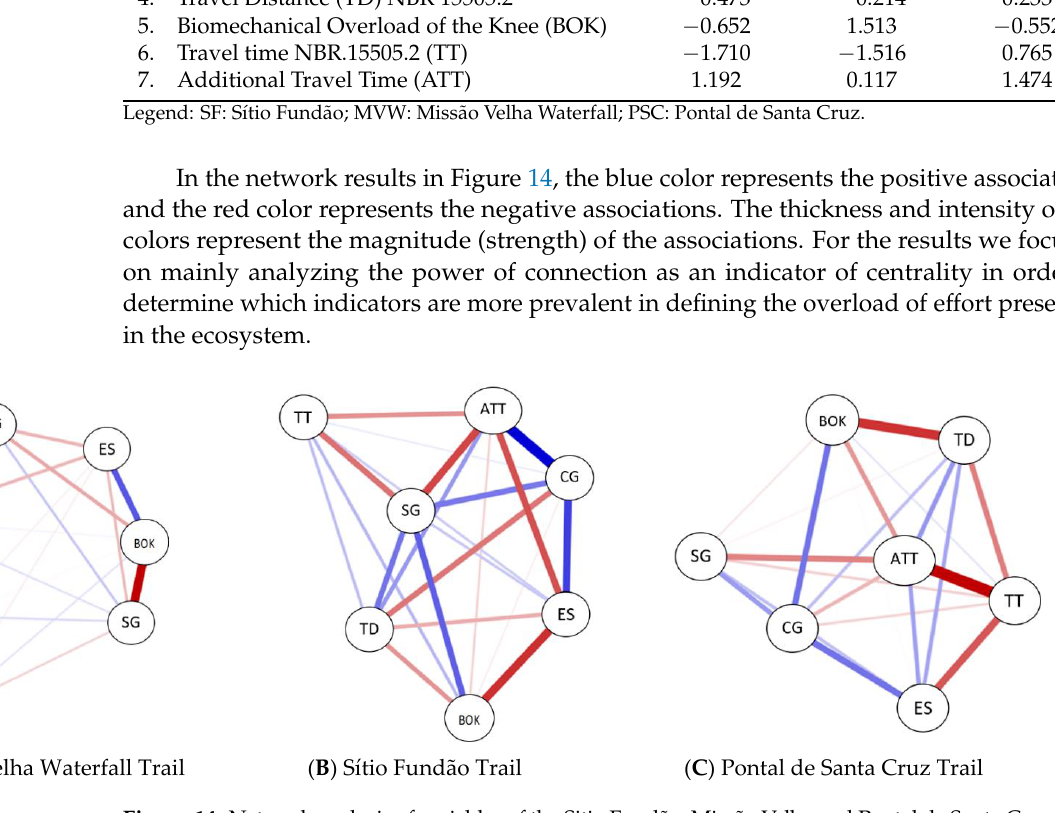
Figure 14. Network analysis of variables of the Sitio Fundão, Missão Velha and Pontal de Santa Cruz trails; Araripe UGG. Legend: 1: ES: Environmental Severity; 2: CG: Course Guidance; 3: SG: Surface and Ground; 4: TD: Travel Distance; 5: BOK: Biomechanical Overload of the Knee; 6: TT: Travel Time (NBR.15505.2); 7: ATT: Additional Travel Time. Positive Associations Negative Associations.